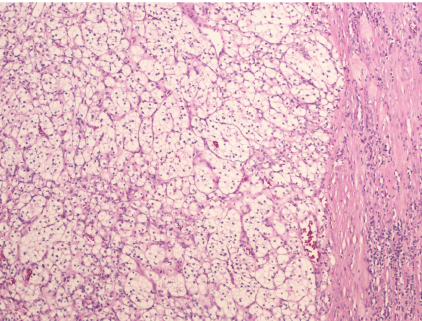
Figure 1: Kidney histopathology: renal cell carcinoma. Clear cell type, comprised of prominent delicate vasculature surrounding alveolar clusters of carcinoma cells.